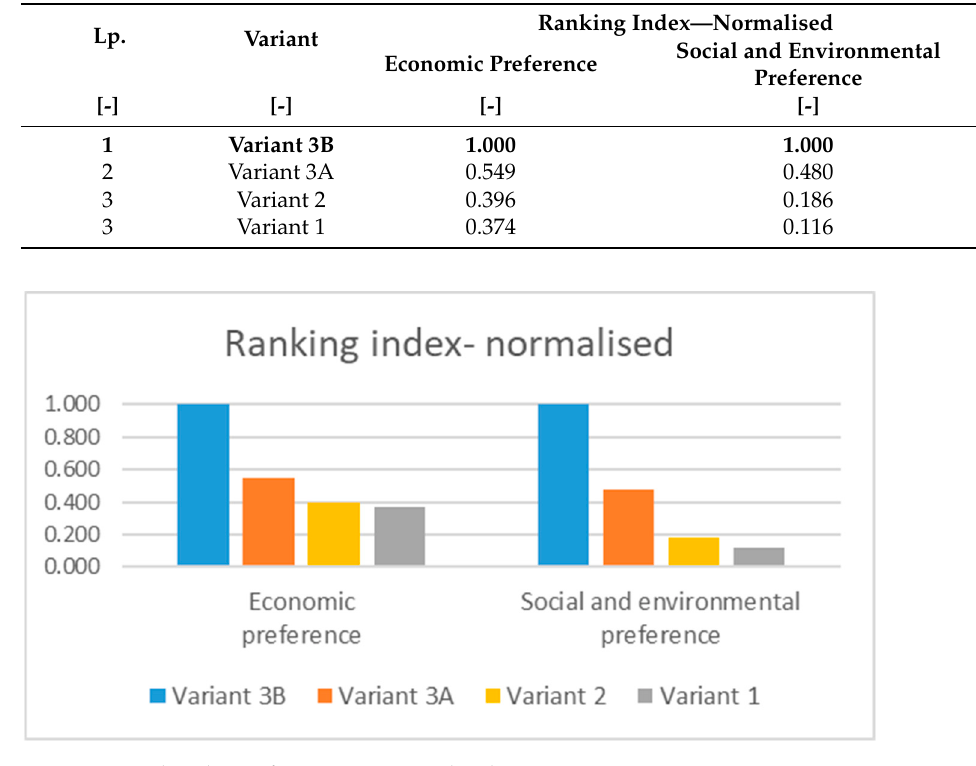
Figure 5. Final ranking of variants—normalised.